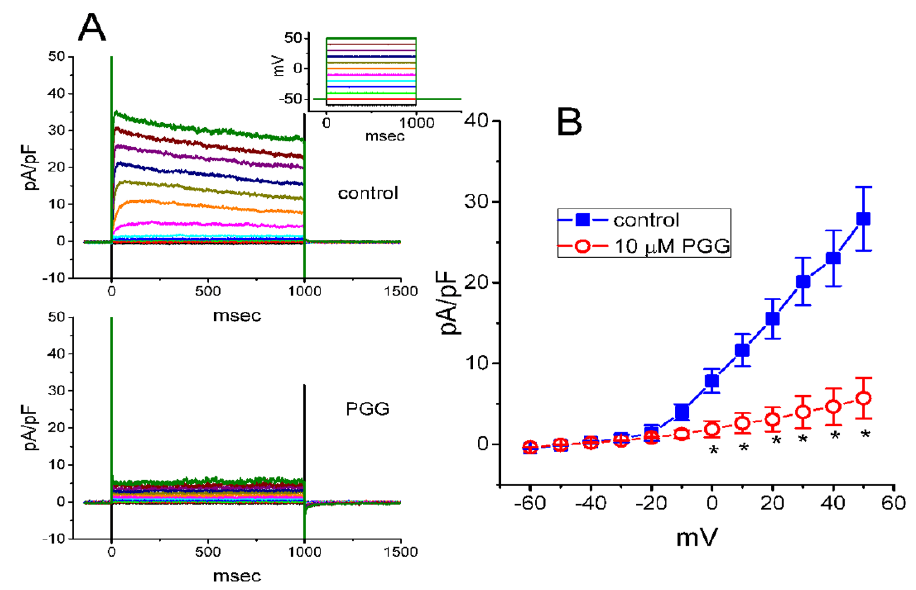
Figure 2. Mean current density versus voltage relationship of I K(DR) obtained without or with the addition of PGG. The examined cells were voltage-clamped at −50 mV with different voltage commands ranging between −60 and +50 mV (representing in inset of the upper part). ( A ) Representative I K(DR) densities achieved in the control (i.e., the absence of PGG; upper part) or during GH 3 -cell exposure to 10 μM PGG (lower part). ( B ) Mean current density versus voltage relationship of I K(DR) in the absence ( ■ ) and presence ( □ ) of 10 μM PGG (mean ± SEM; n = 7). Current density was measured at the end of each step command. The statistical analyses were made by ANOVA-2 for repeated measures, p (factor 1) < 0.05, p (factor 2) < 0.05, p (interaction) < 0.05, followed by post-hoc Fisher’s least-significant difference test, p < 0.05. * indicates a significant difference from controls obtained at the same level of membrane potential ( p < 0.05).